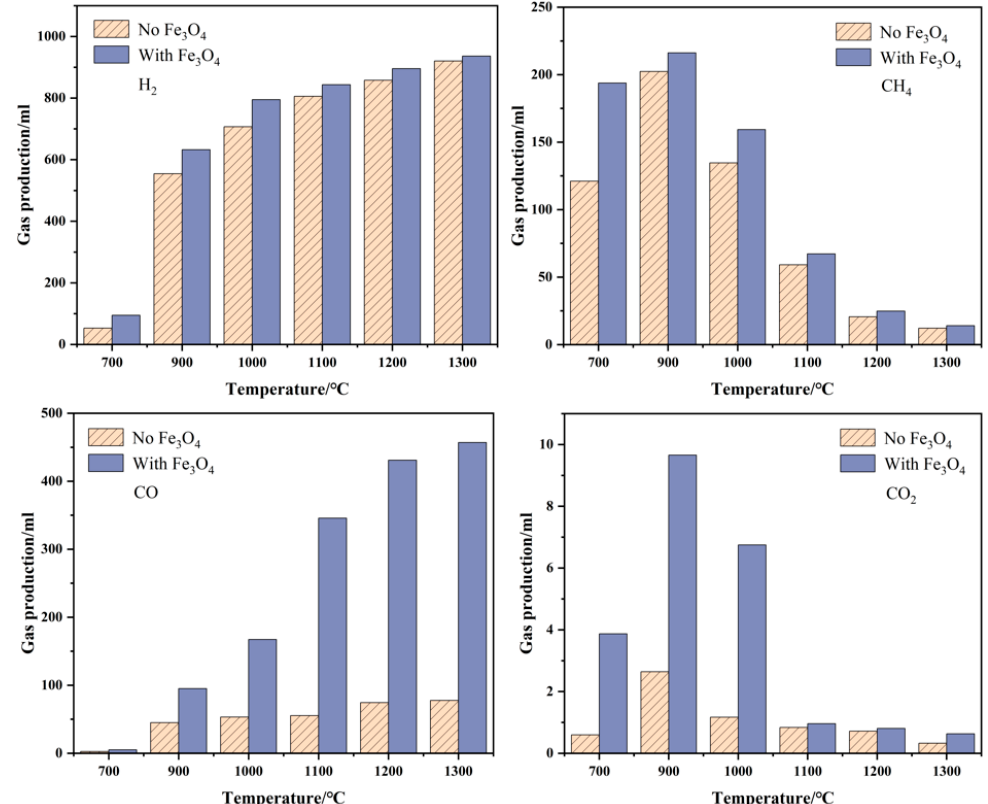
Figure 8. Gas production of WEO at different pyrolysis temperatures.